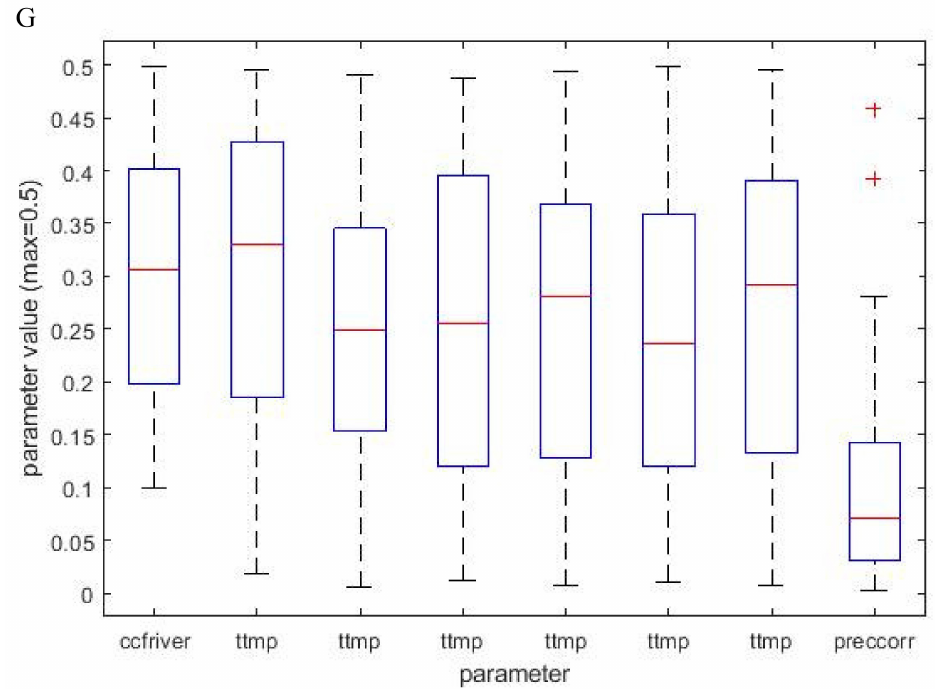
Figure A1. Value distribution in the 100 best parameter sets for all 40 parameters used in initial Monte Carlo analysis. For clarity, the parameters are split between seven di ff erent diagrams based on the maximum value in the Monte Carlo analysis. Calibration was carried out using all four possible combinations in precipitation and temperature datasets. These diagrams were created using Harmonie data [46] for both precipitation and temperature, during the calibration period (1 September 2005–31 December, 2010). ( A ) Parameters with a maximum range in the MC-analysis of 0.05. ( B ) Parameters with a maximum range in the MC-analysis of 0.1. ( C ) Parameters with a maximum range in the MC-analysis of 0.2. ( D ) Parameters with a maximum range in the MC-analysis of 1. ( E ) Parameters with a maximum range in the MC-analysis of 2 (sswcorr), 4 (gratk, gratp and gldepi) or 6 (rivvel). ( F ) Parameters with a maximum range in the MC-analysis of 100 (albedo) or 300 (qmean). ( G ) Parameters with a maximum range in the MC-analysis of